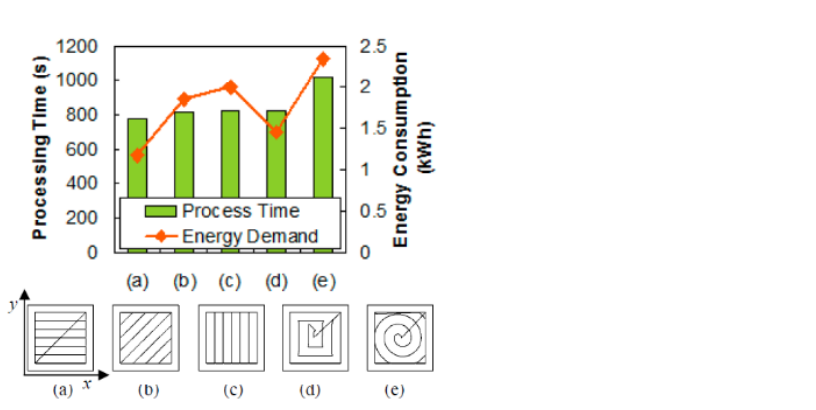
Figure 5. Tool path optimization to shorten product launch